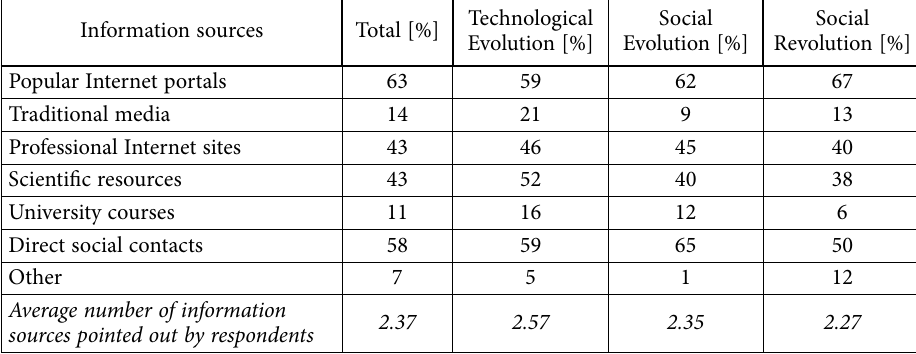
Table 9. Sources of knowledge in relation to expectations Technological Social Social Information sources Total [%] Evolution [%] Evolution [%] Revolution [%] Popular Internet portals 63 59 62 67 Traditional media 14 21 9 13 Professional Internet sites 43 46 45 40 Scientific resources 43 52 40 38 University courses 11 16 12 6 Direct social contacts 58 59 65 50 Other 7 5 1 12 Average number of information 2.37 sources pointed out by respondents